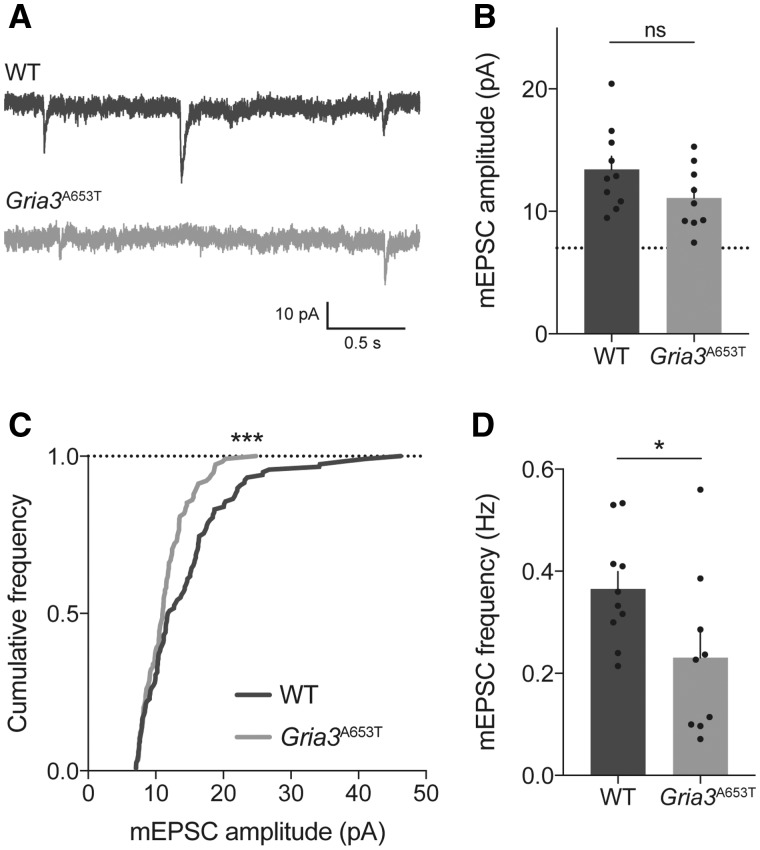

Gria3
A653T mice show impaired synaptic transmission. (A) Example traces of AMPAR mEPSC recordings from cerebellar Purkinje cells of wild type (WT) and Gria3A653T mice. (B) Average mEPSC amplitude per cell (WT: 13.44 ± 1.06 (n = 10 cells); Gria3A653T: 11.09 ± 0.876 (n = 9); unpaired t-test, P = 0.111). (C) Cumulative frequency distributions of a representative subset of mEPSC amplitudes show a reduction in large amplitude mEPSCs in Gria3A653T mice. Frequency distributions, when fitted with a skewed normal curve (not depicted), are significantly different between populations (F-test, P = 0.0001, F(3, 36) = 9.18). (D) mEPSC frequency was significantly lower in Gria3A653T mice when compared to WT (WT: 0.37 ± 0.03 (n = 10); Gria3A653T: 0.23 ± 0.05 (n = 9); unpaired t-test, P = 0.0467).